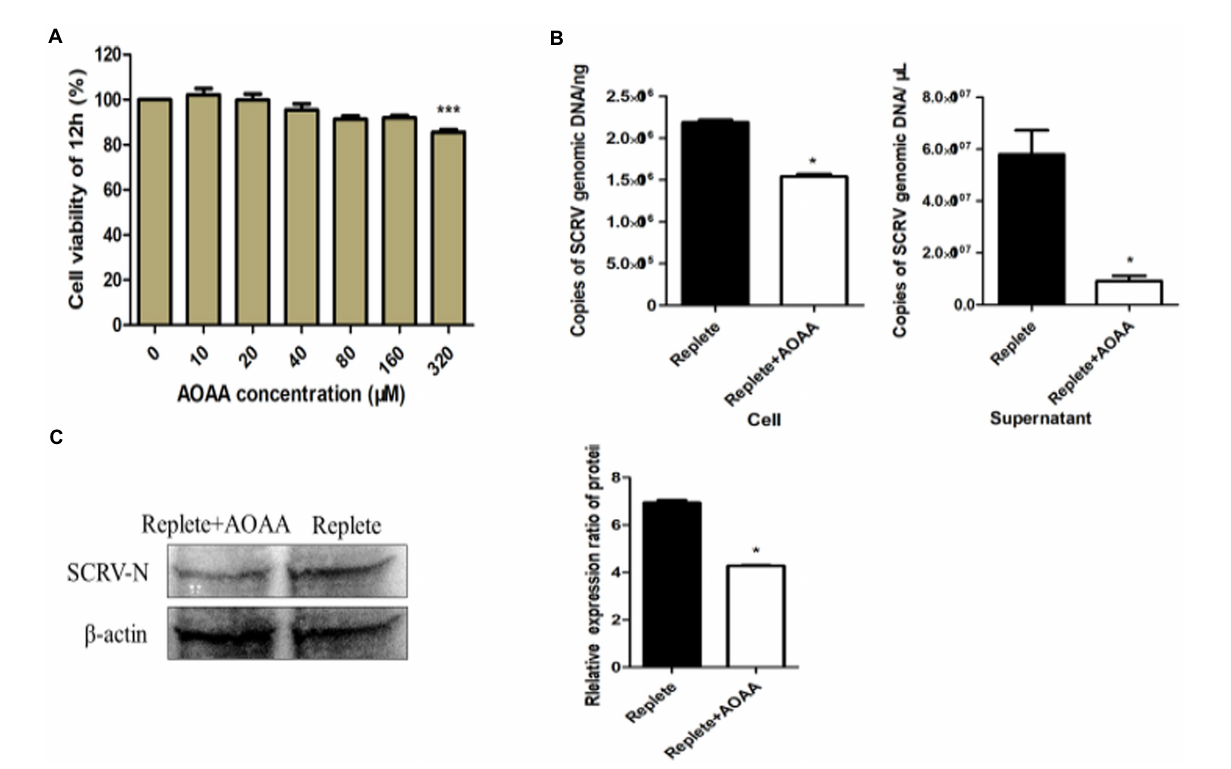
FIGURE 4 Inhibition of the aspartate-malate shuttle affects SCRV replication. (A) Cell viability with added inhibitors. Different concentrations of aminooxyacetic acid hemihydrochloride (AOAA) were added to glutamine medium, and after 12 h of treatment, cell viability was determined by CCK-8 assay. The activity of mock-treated samples was assigned as 100%. (B) Effect of addition of inhibitor AOAA on SCRV virus yield. CPB cells were infected with SCRV at an MOI of 1 in the presence or absence of AOAA (100 μ mol) in glutamine medium, intracellular and supernatant SCRV were harvested at 12 hpi, and virus production was determined by qPCR. (C) Expression of SCRV viral proteins by adding inhibitor AOAA. CPB cells were infected with SCRV at an MOI of 1 in the presence or absence of AOAA (100 μ mol) in glutamine medium, and intracellular proteins were collected at 12 hpi, and the expression of SCRV-N protein was detected by western blot analysis. NS, p ≥ 0.05, * p ≤ 0.05, ** p ≤ 0.01, *** p ≤ 0.001. (unpaired Student’s t -test). Data are representative of three different independent experiments (mean ±